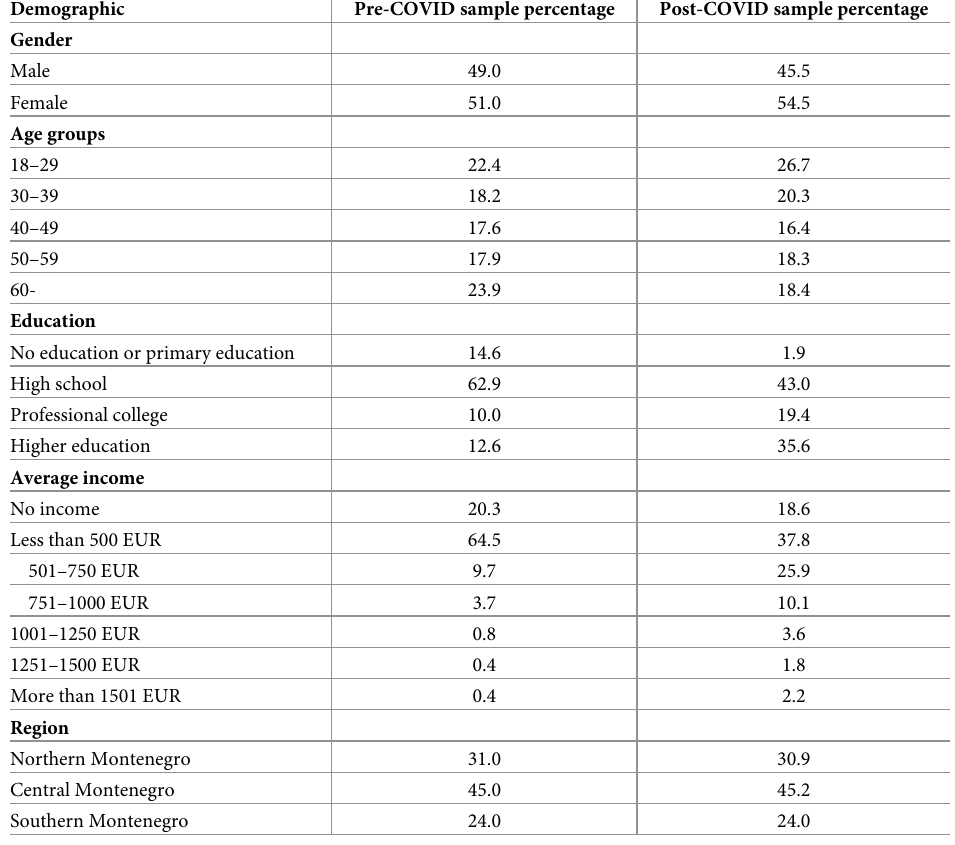
Table 1. Socio-demographic characteristics of the sample in pre-COVID and post-COVID